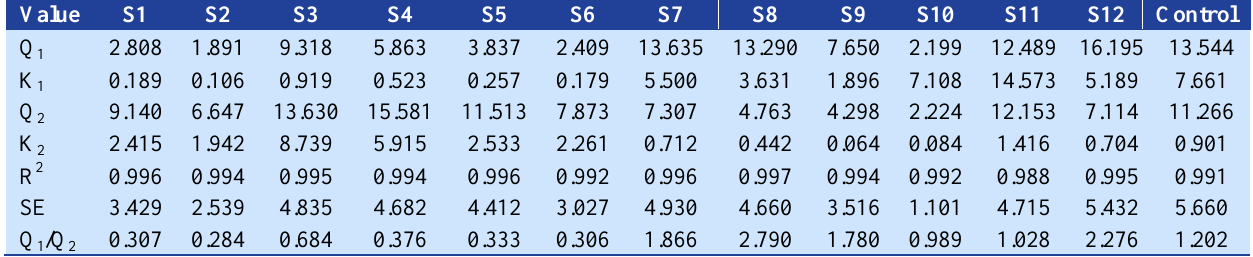
Table 5. Estimated parameters of the two first-order reaction model used to describe release kinetics of Cr with 0.01 m EDTA